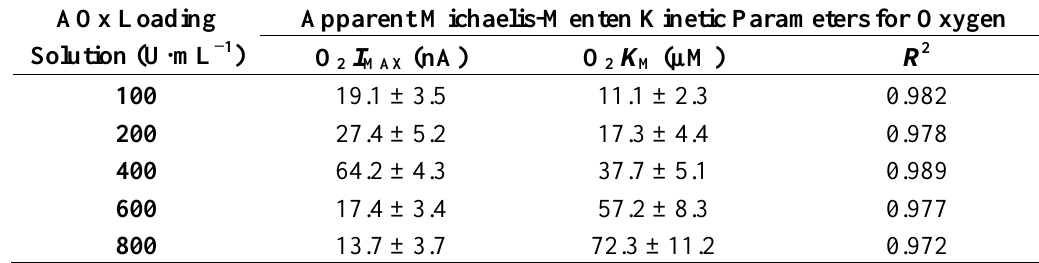
Table 3. Oxygen dependence study at Day 1. In-vitro characterization of the same biosensor groups shown in Tables 1 and